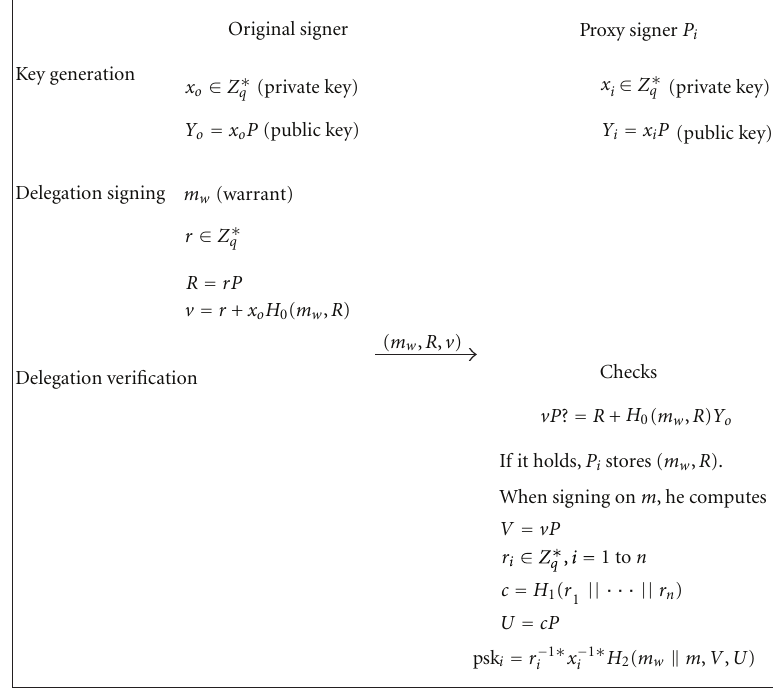
Figure 3: The delegation signing and delegation verification phases of our scheme.